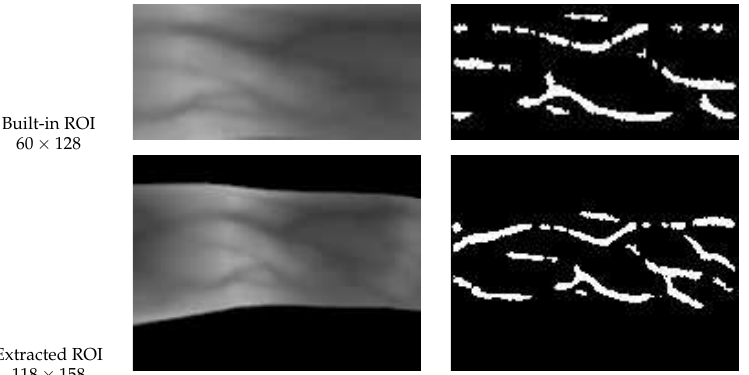
Figure 8. Sample diagram from MMCBNU database, the first row is the built-in ROI image and its corresponding RLF-based vein feature, while the second row is derived from our adopted ROI localization strategy [62] and its corresponding RLF-based vein feature.